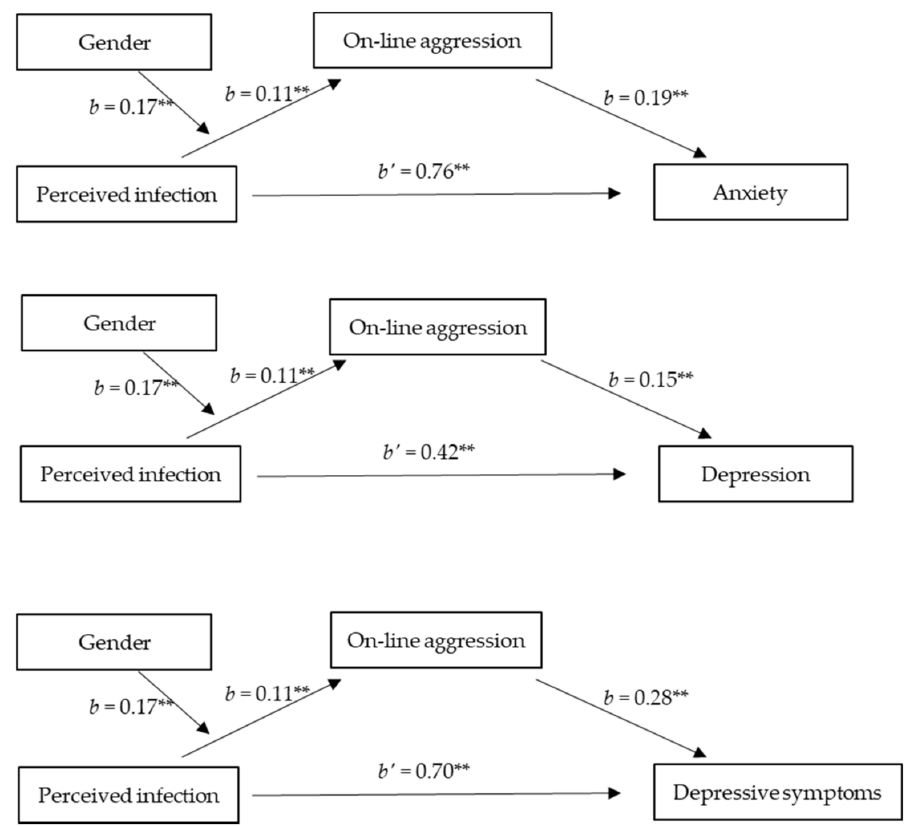
Figure 5. Moderated mediation models in Study 2. ** p < 0.01. Table 3. The moderated mediation effect of perceived infection on anxiety, depression, and depressive disorder. Anxiety Gender